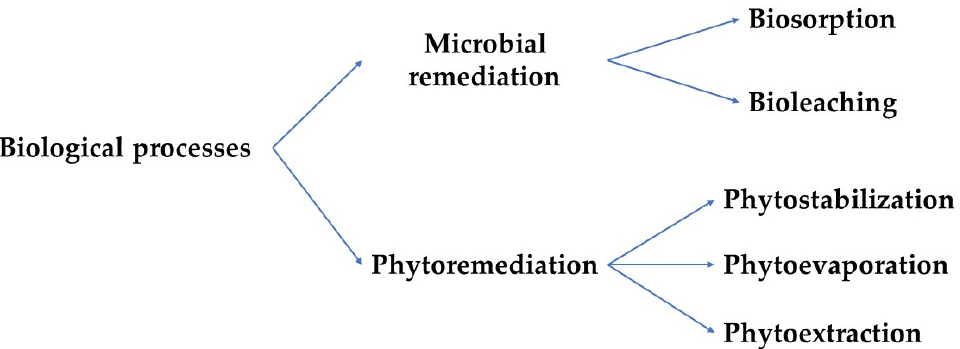
Figure 5. Biological processes to remove heavy metals and metalloids.